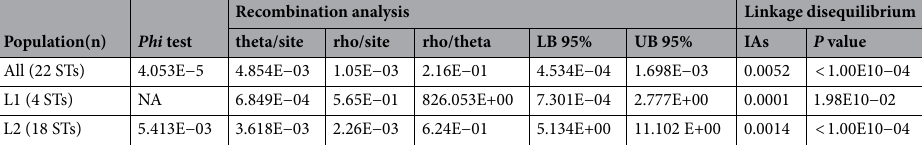
Table 3. Recombination test and estimation of Staphylococcus aureus . Contains 22 Sequence types ( All ); Lineage 1 ( L1 ); Lineage 2 ( L2 ); Standard association of index ( IAs ); Upper bound 95% ( LB) ; Lower bound 95% (